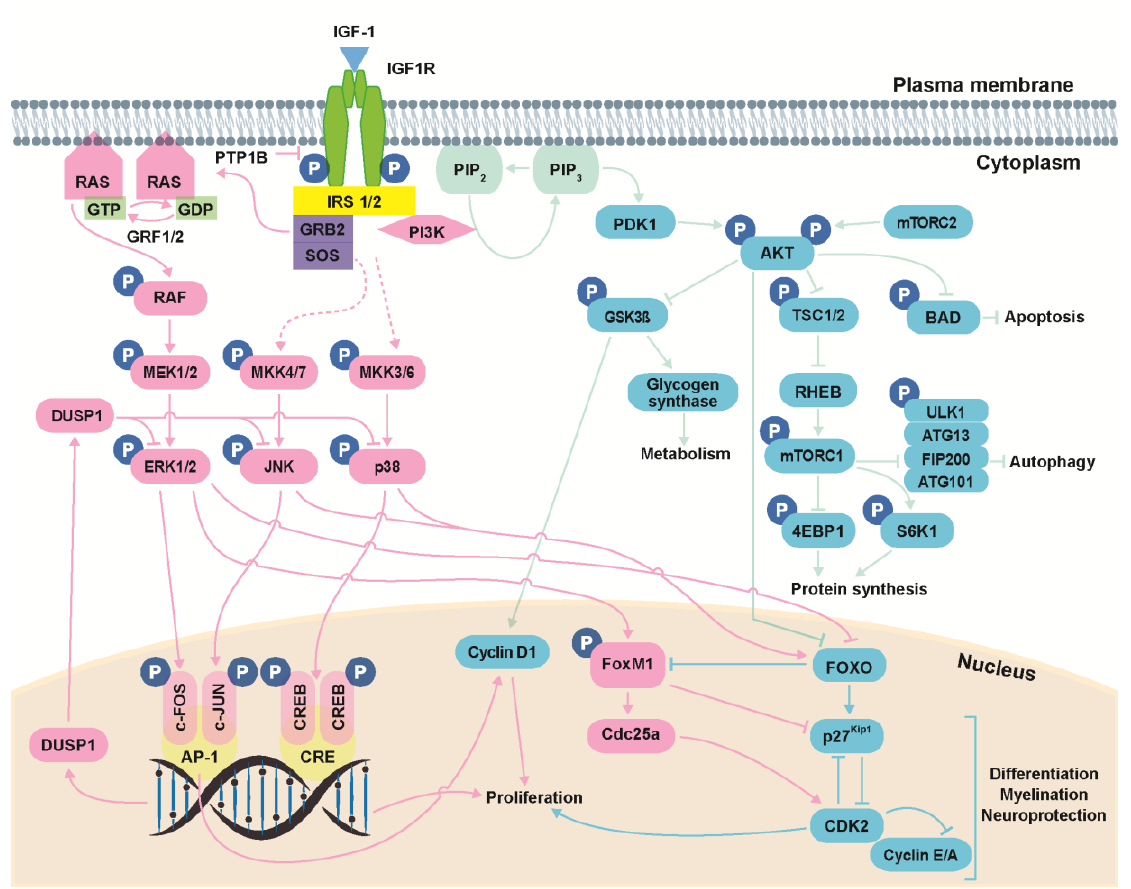
Figure 2. IGF-1 signaling. Activation of IGF1R can result in signaling via three main pathways: PI3K/AKT, ERK/MAPK and stress kinases (p38 and JNK). The PI3K/AKT pathway modulates cell survival, autophagy, protein synthesis and glucose metabolism; the ERK/MAPK pathway regulates cell growth and differentiation, among other processes; and the stress kinase (p38 and JNK) cascades regulate stress response, proliferation, differentiation, migration and survival. Kinase actions are strictly regulated by phosphatases. PTP1B, protein tyrosine phosphatase 1B; IRS, insulin receptor substrate; GRB2, growth factor receptor-bound protein 2; SOS, son of sevenless; RAS, rat sarcoma; RAF, rapidly accelerated fibrosarcoma; ERK, extracellular signal-regulated kinase; MAPK, mitogen-activated protein kinase; JNK, c-JUN N-terminal kinases; PDK1, phosphoinositide-dependent protein kinase 1; PIP2, phosphatidylinositol 4,5-bisphosphate; PIP3, phosphatidylinositol (3,4,5)-trisphosphate; PI3K, phosphatidylinositol 3-kinase; AKT, thymoma viral proto-oncogene; mTORC1, mammalian target of rapamycin complex 1; mTORC2, mammalian target of rapamycin complex 2; GSK3 β , glycogen synthase kinase-3 β ; TSC1, tuberous sclerosis complex-1; TSC2, tuberous sclerosis complex-2; RHEB, RAS homolog enriched in brain; ULK1, unc-51-like kinase 1; ATG13, mammalian autophagy-related gene 13; FIP200, focal adhesion kinase family-interacting protein of 200 kDa; ATG101, mammalian autophagy-related gene 101; S6K1, p70S6 Kinase 1; 4EBP, eukaryotic translation initiation factor 4E-binding protein; FOXO, forkhead box O; FOXM1, forkhead box protein M1. Data have been compiled from